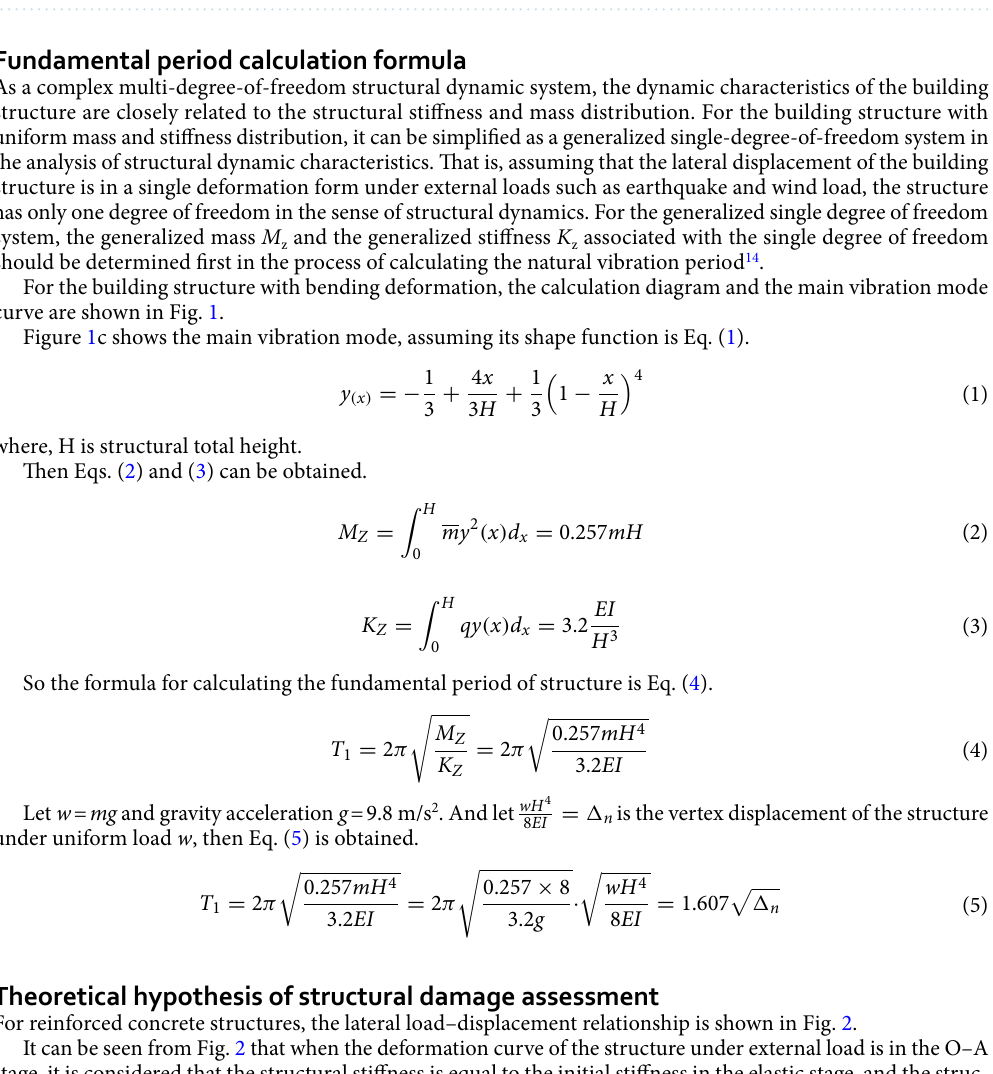
Figure 1. Mechanical diagram and main vibration mode curve diagram of building